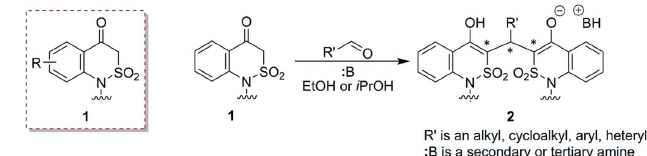
Figure 1 The structures of 2,1-benzothiazin-4(3 H )-one 2,2-dioxides 1 and stable enolates 2 (‘B 0 is the rest of a secondary or tertiary